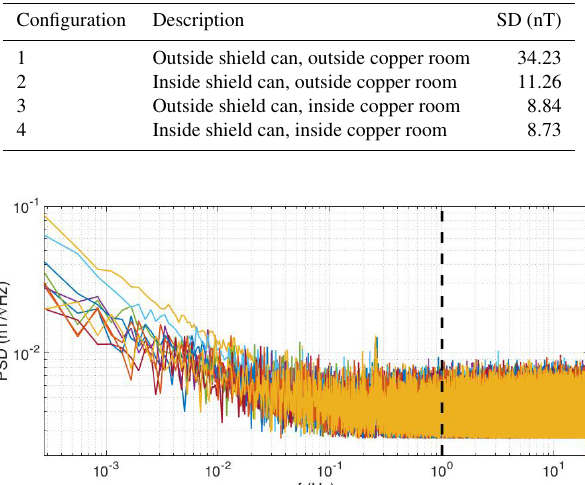
Table 2. Resolution tests setup and results.